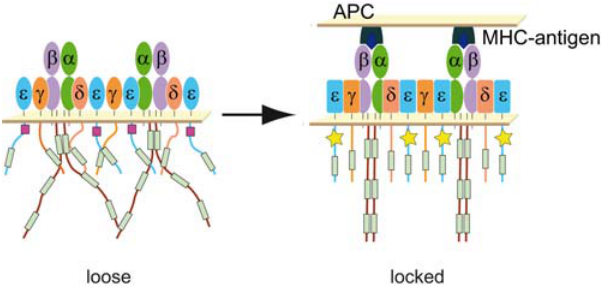
Figure 4. Model of conformational change in the cytoplasmic tails of CD3 subunits after TCR engagement. In non-stimulated cells, the CD3 subunits in the TCR are in a loose conformation that is accessible to trypsin digestion. The PPS of CD3 e (pink square) is in a non-binding conformation for Nck. After TCR engagement with pMHC or with stimulatory antibodies, the CD3 ectodomains adopt an active conformation (symbolized with rectangular forms) that is transmitted to the cytoplasmic tails of the CD3 subunits via a rotation and/or scissor movement. The cytoplasmic tails close up to form a compact structure that is less sensitive to proteolytic attack. This conformation permits Nck-binding by CD3 e .